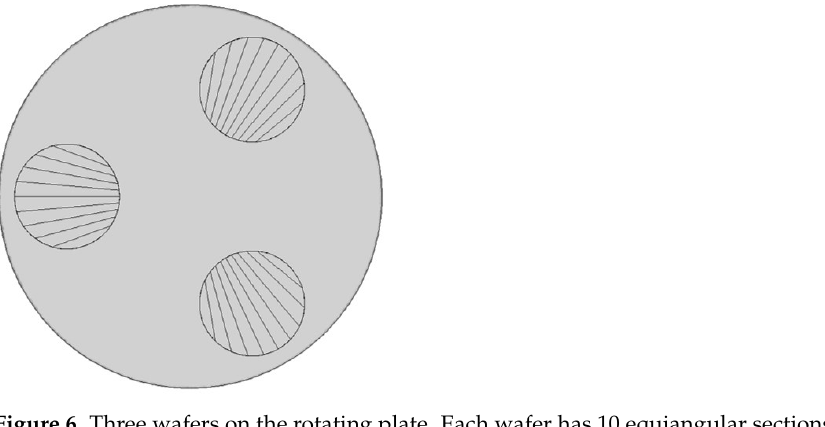
Figure 6. Three wafers on the rotating plate. Each wafer has 10 equiangular sections to evaluate 10 surface area-averaged pressures to evaluate an averaged surface coverage, and source generation and consumption